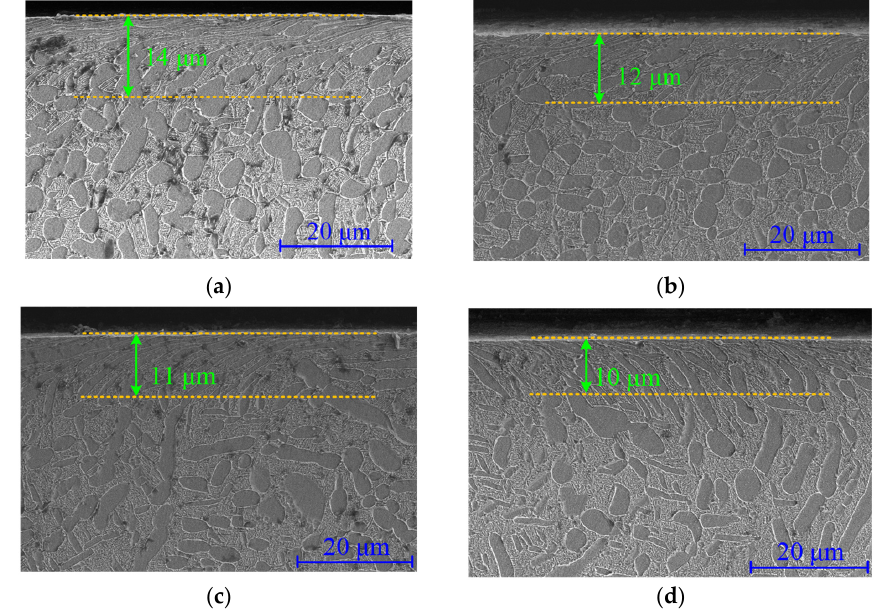
Figure 11. Microstructure characteristics of turned surface during fatigue process. ( a ) 0 cycle; ( b ) 9.66 × 10 3 cycles; ( c ) 9.66 × 10 4 cycles; ( d ) 9.66 × 10 5